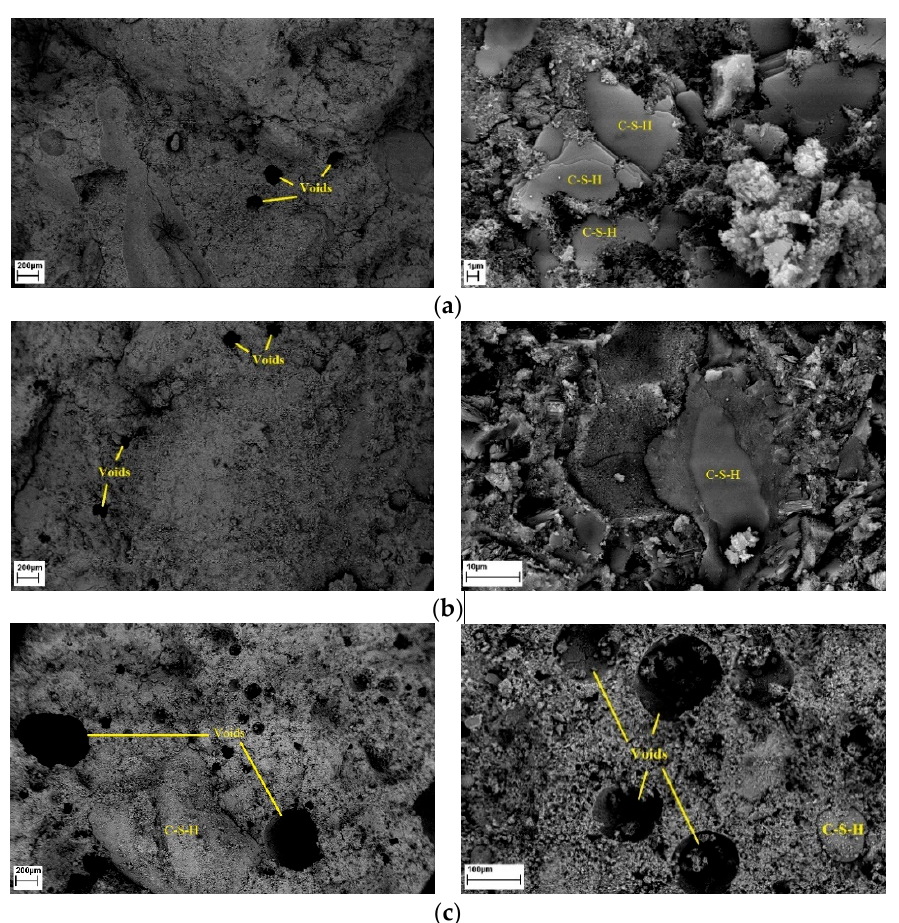
Figure 20. SEM images of Ctrl ( a ), RGE5 ( b ), and RGE50 ( c ) mixes.